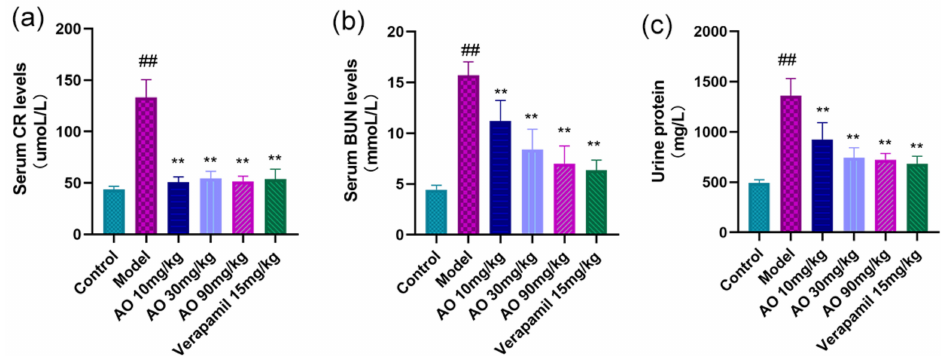
Figure 3. Effects of AO on kidney function indexes in AKI rats. ( a ) Serum creatinine, ( b ) blood urea nitrogen, and ( c ) urinary protein were measured on the first day after the last administration. The data are expressed as means ± standard deviation; compared with the model group, ** p < 0.01; compared with the control group, ## p < 0.01 ( n = 6).